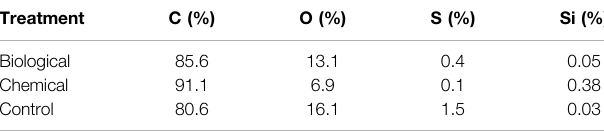
TABLE 2 | Elemental distribution of C, O and S on rubber particles after biological and chemical desulfurization treatments.